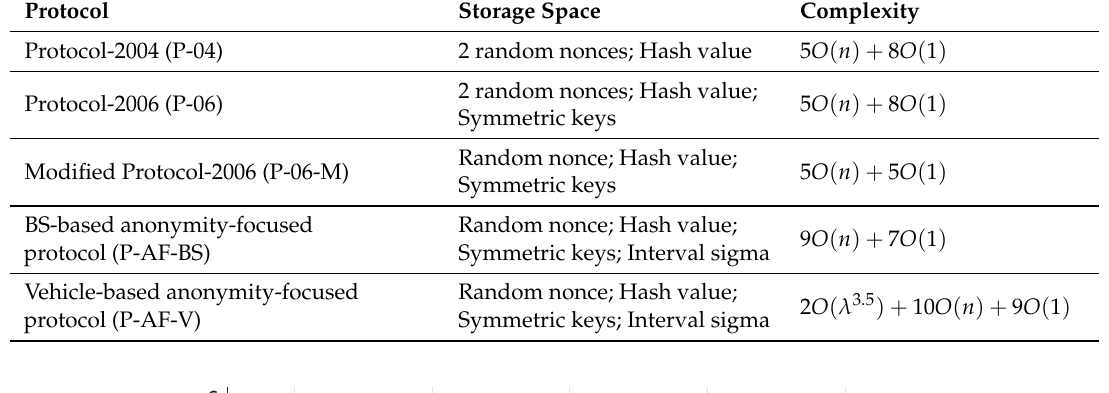
Table 2. The complexity evaluation.